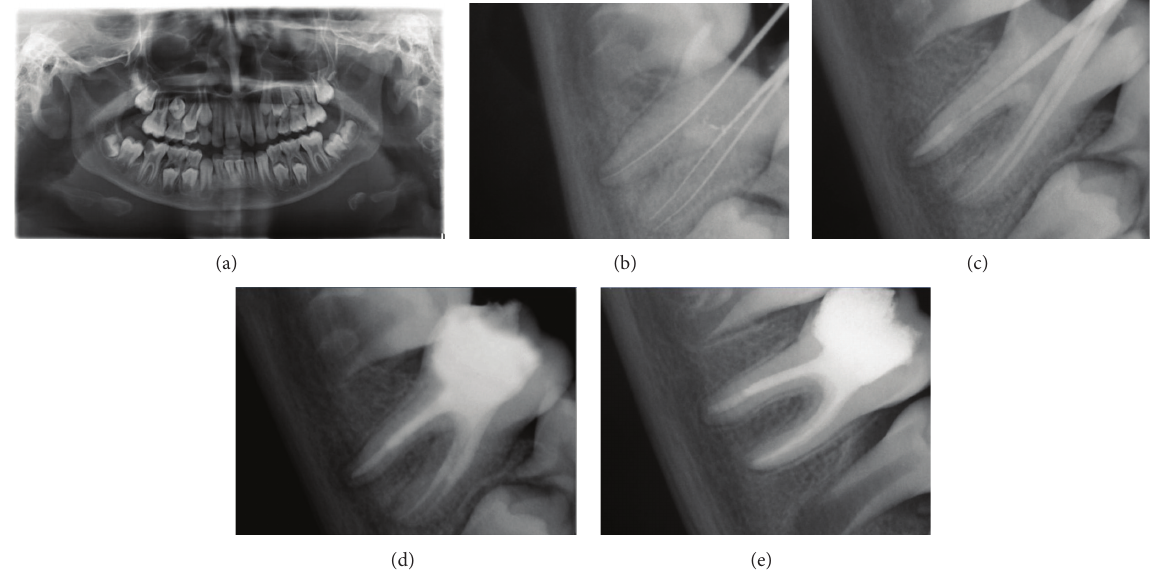
Figure 2: (a) Preoperative. (b) Working length determination. (c) MTA apical plug of 4-5mm thickness. (d) Final obturation. (e) After 8-month reassessment, continuous lamina dura and consistent width of periodontal ligament space suggest healing of the periapical